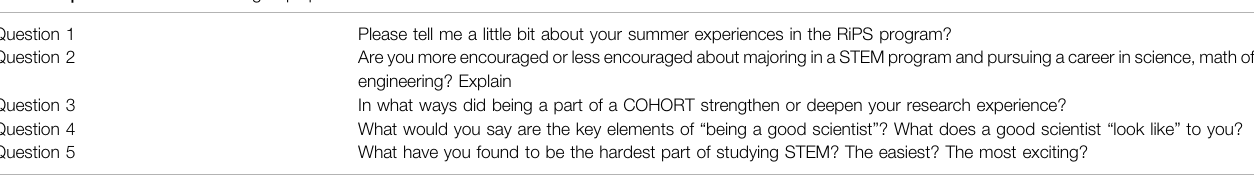
TABLE 5 | Semi-structured focus group